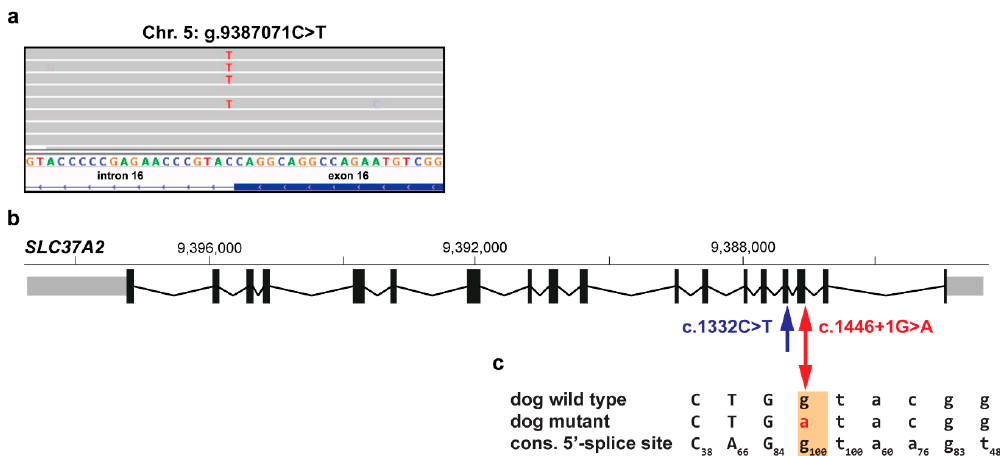
Figure 3. Characterization of the most likely pathogenic variant in SLC37A2 in the CMO-affected Basset Hound. ( a ) IGV snapshot showing the heterozygous splice site candidate variant (NC_006587.3:g.9387071C>T). ( b ) Schematic representation of the SLC37A2